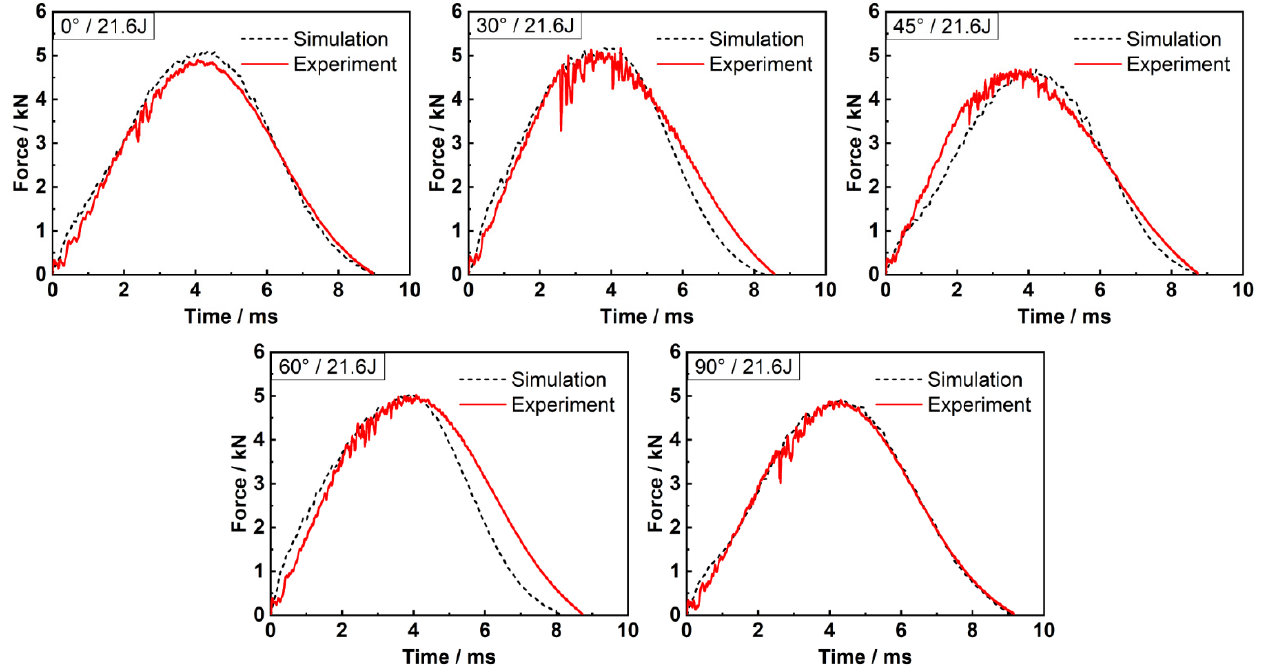
Figure 2. Force-time relations under 21.6 J of impact Figure 2 . Force-time relations under 21.6 J of impact energy.